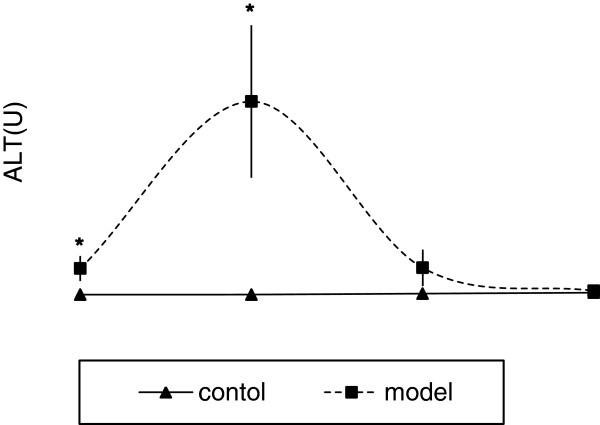
The degree of liver injury caused by metastasis was recovered on day 12. The level of alanine aminotransferase (ALT) in the serum was used as a marker of liver injury. The ALT levels increased to the maximum level on the 6th day (Day 6) after inoculation and returned to the control level on the 12th day (Day 12). On the 3rd (Day 3) and 6th day (Day 6), the ALT levels in the model rats were significantly higher than in the control rats, p < 0.05(*), (n = 3 for each group).